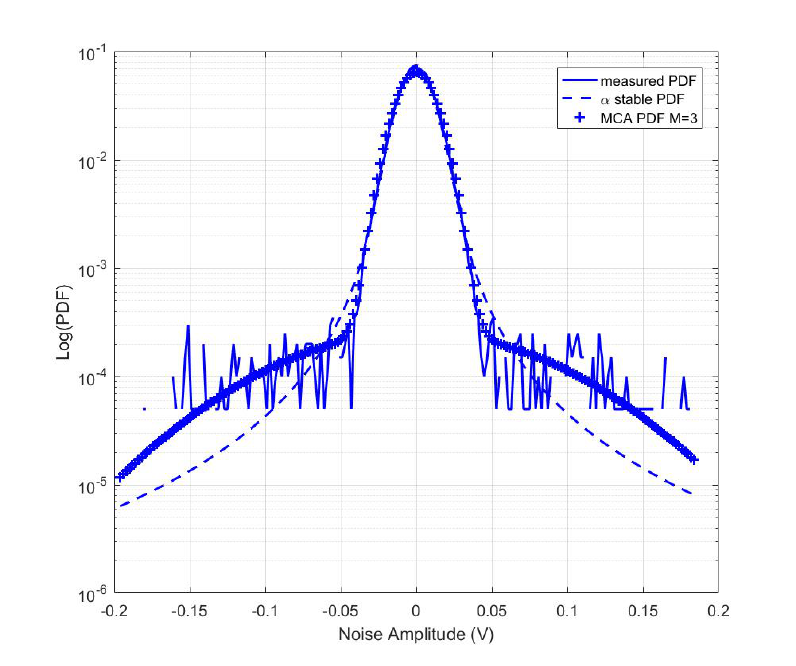
Figure 12. log(PDF) comparison of MCA, α stable model and measured noise data in